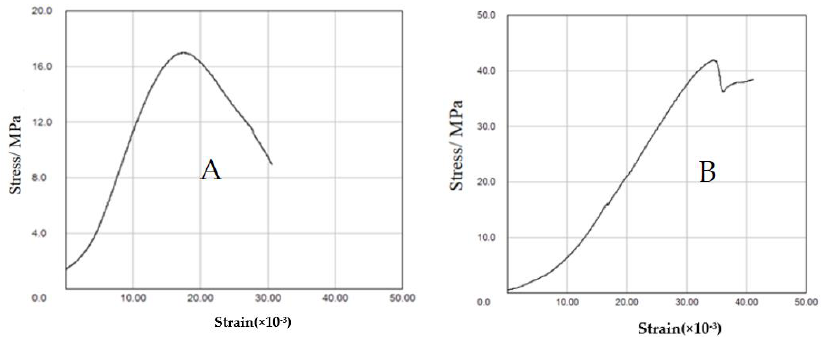
Figure 1. RMT − 301 test results of similar materials. ( A ) Uniaxial compressive strength of mudstone- like materials; ( B ) uniaxial compressive strength of sandstone-like materials.